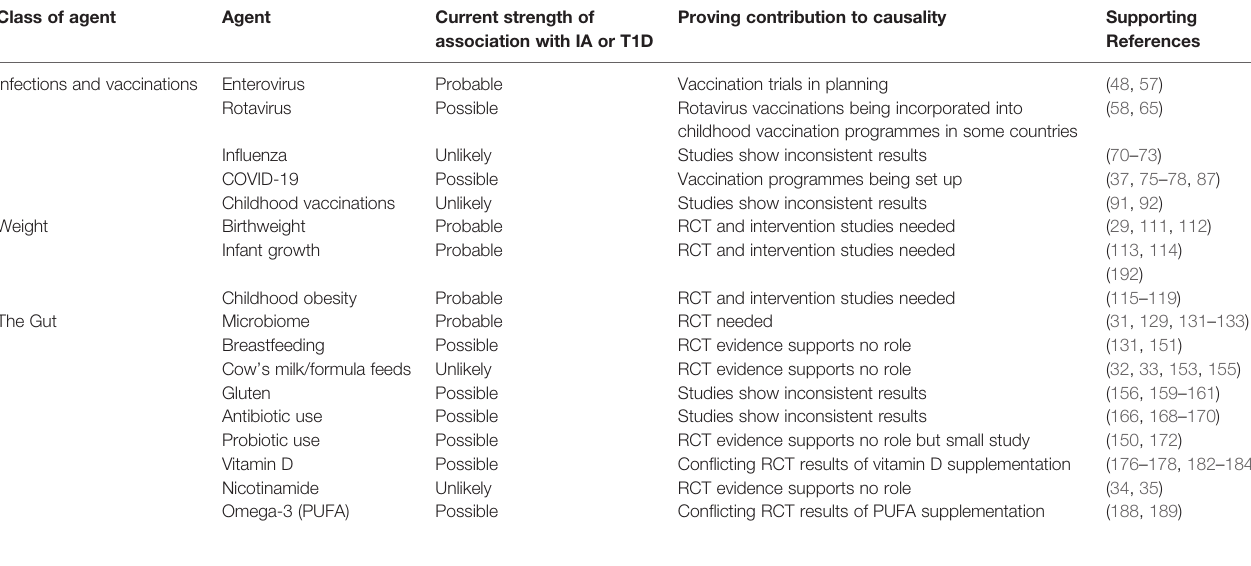
TABLE 1 | List of the key environmental determinants outlined in this review and the evidence supporting a causal framework. Class of